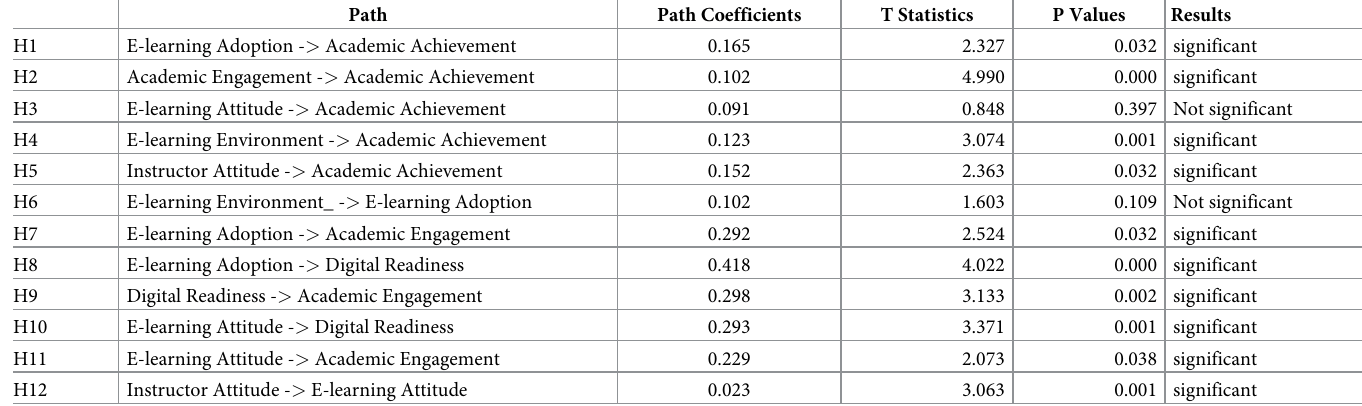
Table 5. Hypotheses, path coefficients, and